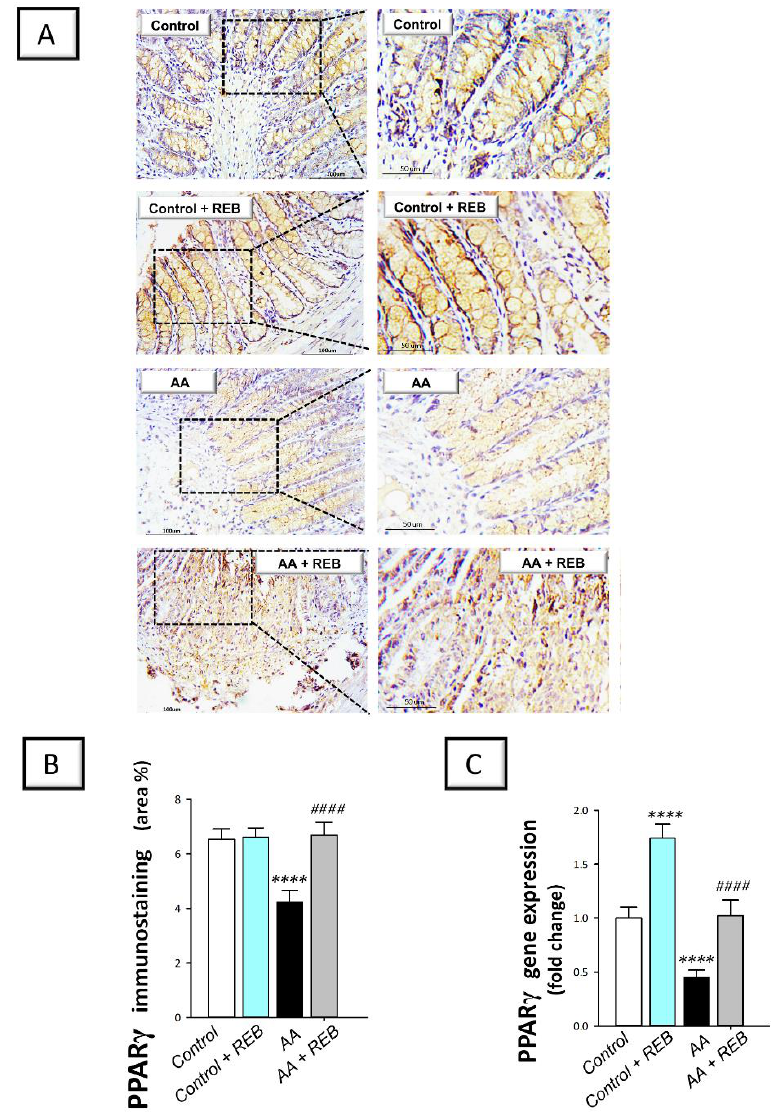
Figure 9. Rebamipide replenishes the colonic cytoprotective signal PPAR-γ in rats exposed to acetic acid-induced colitis. ( A ) Immunostaining of the peroxisome proliferator-activated receptor gamma (PPAR-γ) in the colonic tissue. ( B ) Quantification of colonic PPAR-γ immunostaining. ( C ) Gene expression levels of PPAR-γ in the colonic tissue. Each bar represents the mean ± S.D. ( n = 6). A one- groups followed by a Tukey’s test. **** p < 0.0001, significant from the control group. # ### p < 0.0001,